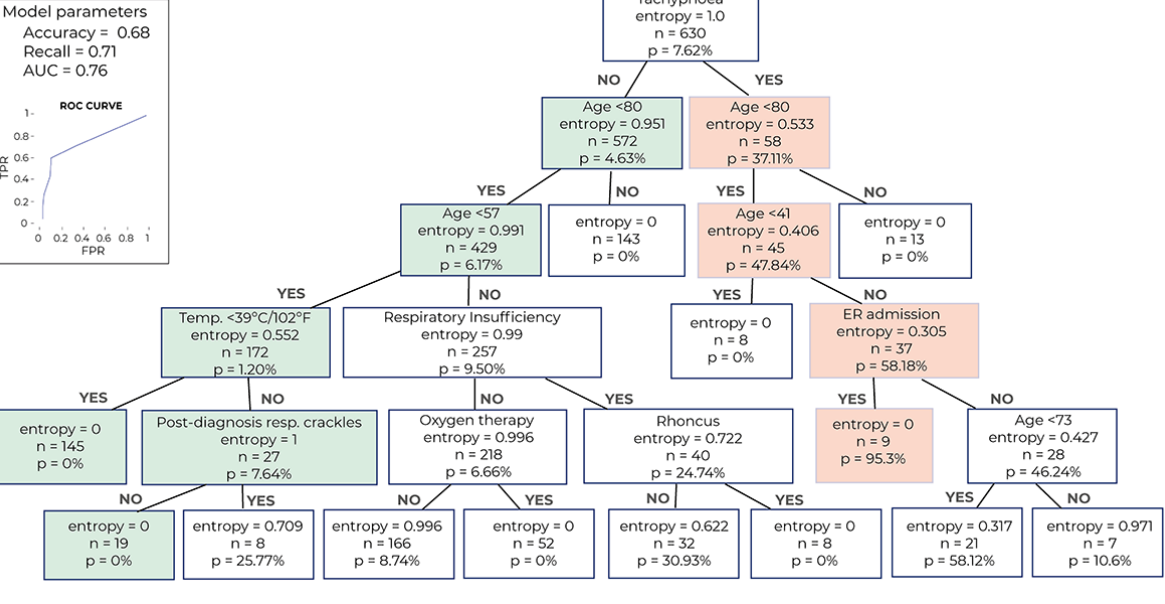
b P values from Yates-corrected chi-square tests of differences between percentages of patients in either outcome group. All tests were performed individually for each variable (sign, symptom, or comorbidity, where applicable). c List of medical conditions according to Systematized Nomenclature of Medicine Clinical Terms terminology. d COPD: chronic obstructive pulmonary disease. e